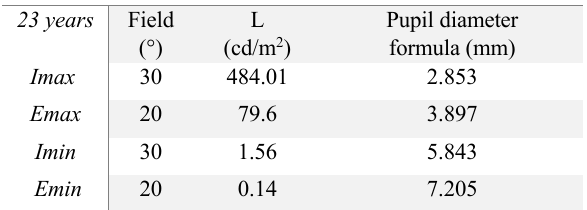
Table 3. Theoretical results of pupillary diameters calculat- ed with the formulas of Watson & Yellott (Watson & Yellott, 2012) for the different lighting conditions for iPad and